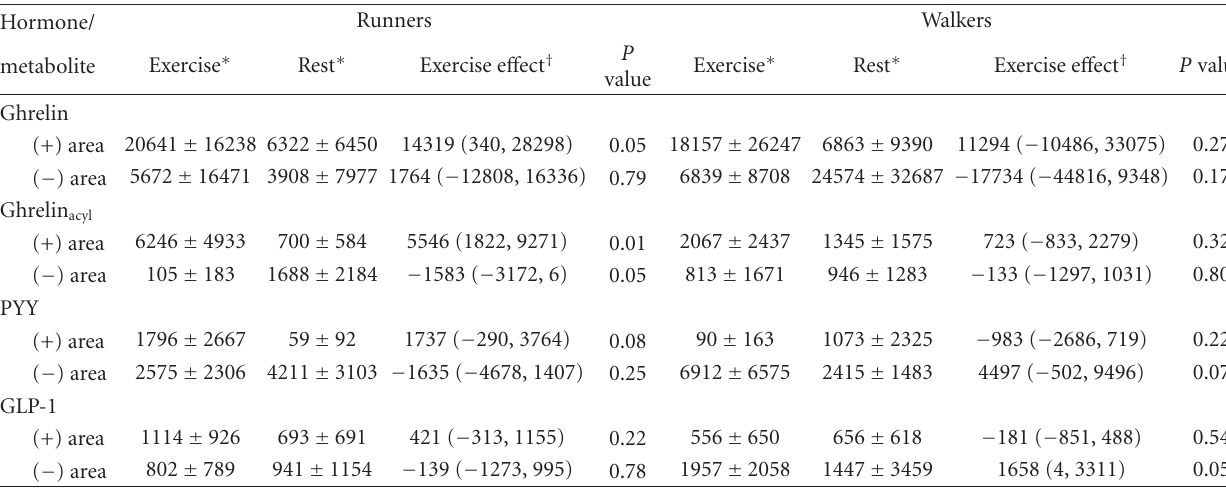
Table 4: E ff ect of exercise on AUC values for hormones and metabolites. Results for both positive and negative AUC are presented. Hormone/ Runners Walkers metabolite